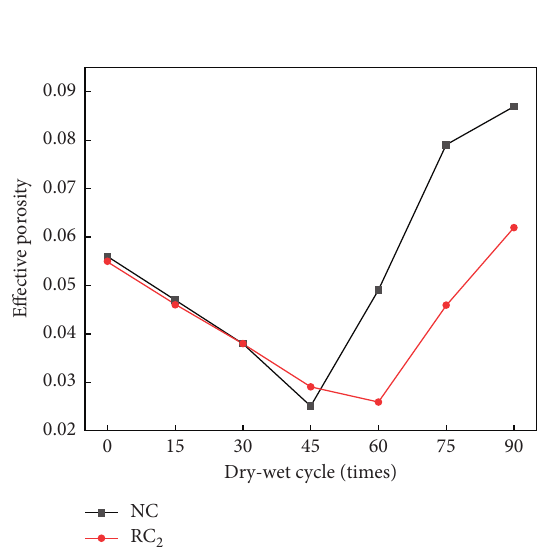
Figure 7: Elastic strain energy. (a) NC. (b) RC.